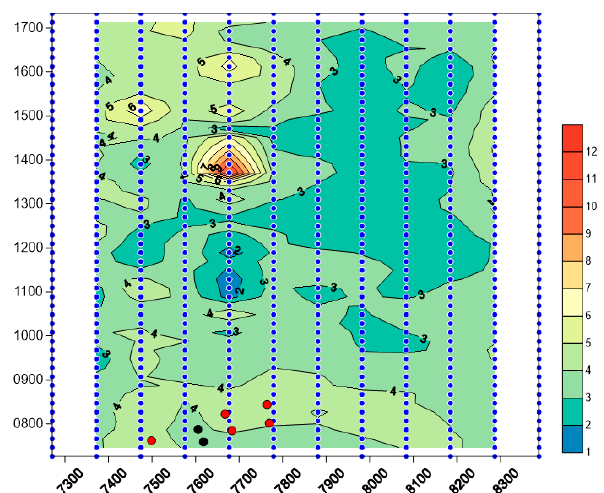
Figure 8. The natural neighbor interpolation contour map. The red and black symbols are the logging well with and without gold mine, respectively.